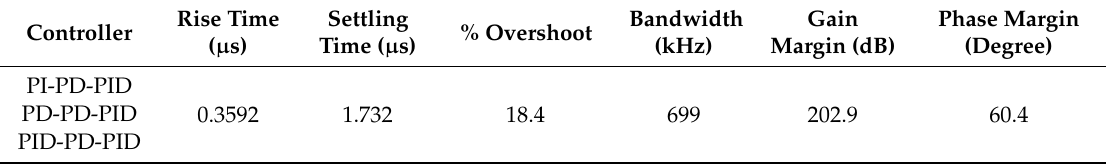
Table 1. Summary of the proportional plus integral plus derivative (PID) controller.